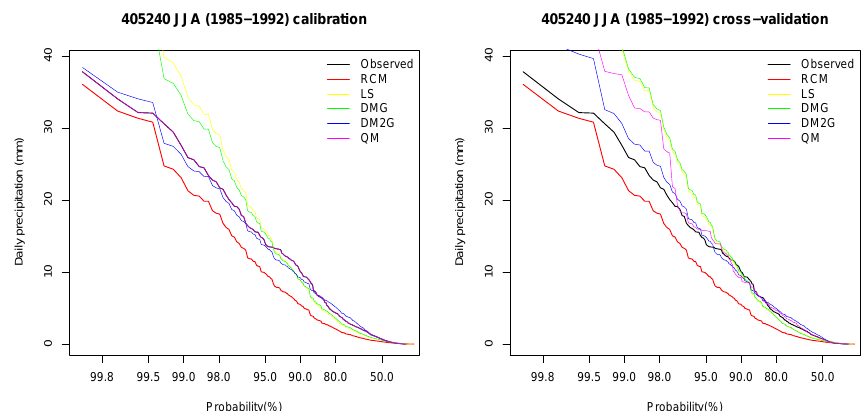
Figure 11. Comparison of CDFs derived from observed, raw RCM and bias-corrected RCM daily precipitation data for one study catchment. The left plot shows calibration results (note that the observed precipitation is completely hidden by QM in this plot) and the right plot shows cross-validation